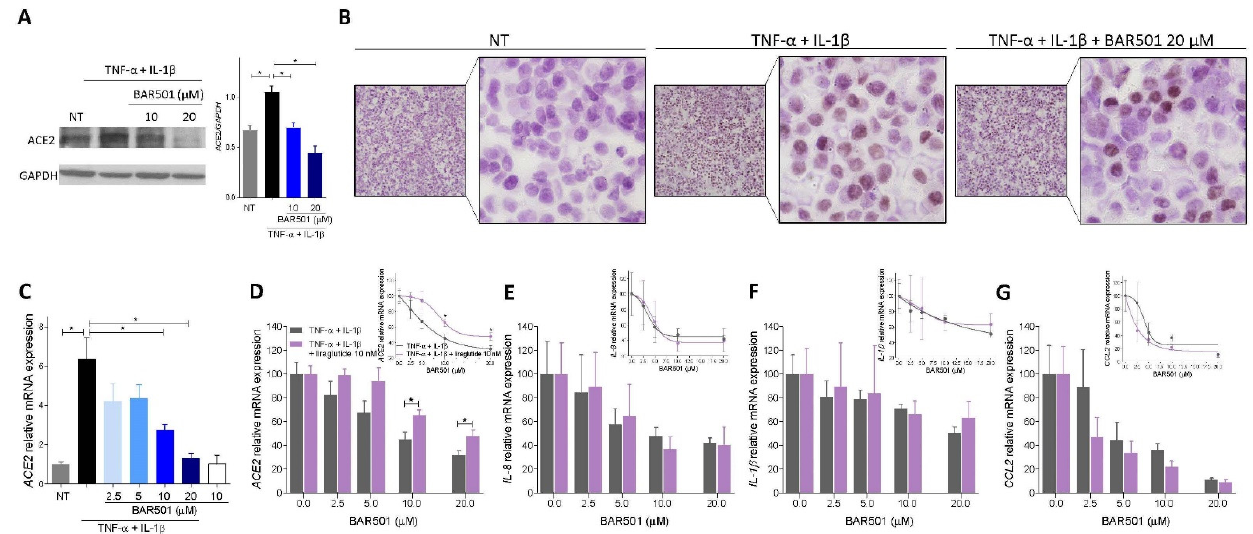
Figure 8. Liraglutide potentiates the anti-inflammatory activity of GPBAR1 in vitro. ( A ) Western blot analysis of Ace2 expression in HT29 cells in presence of BAR501 at 10 and 20 μ M and densitometric analysis performed with Image J from blots corresponding to all samples, data are presented as mean ± SE relative to GAPDH. ( B ) Immunocitochemistry with anti-ACE2 antibody on HT29 cells (Magnification 4× and 10×). ( C ) Quantitative real-time PCR analysis of Ace2 expression in Ht29 cell line activated with TNF- α 100 ng/mL an IL-1 β 25 ng/mL for 24 h alone or in combination with BAR501 at different concentration (2.5, 5, 10, 20 μ M). Relative mRNA expression of ( D ) Ace2, ( E ) Il-8, ( F ) IL-1 β and ( G ) Ccl2 in HT29 cell line exposed to different conditions (TNF- α 100 ng/mL an IL-1 β 25 ng/mL for 24 h alone or in combination with liraglutide (10 nM) and BAR501 at increasing concentrations (2.5, 5, 10, 20 μ M) evaluated by real-time PCR. The data are normalized to GAPDH mRNA. Results are expressed as mean ± SEM; * p < 0.05.